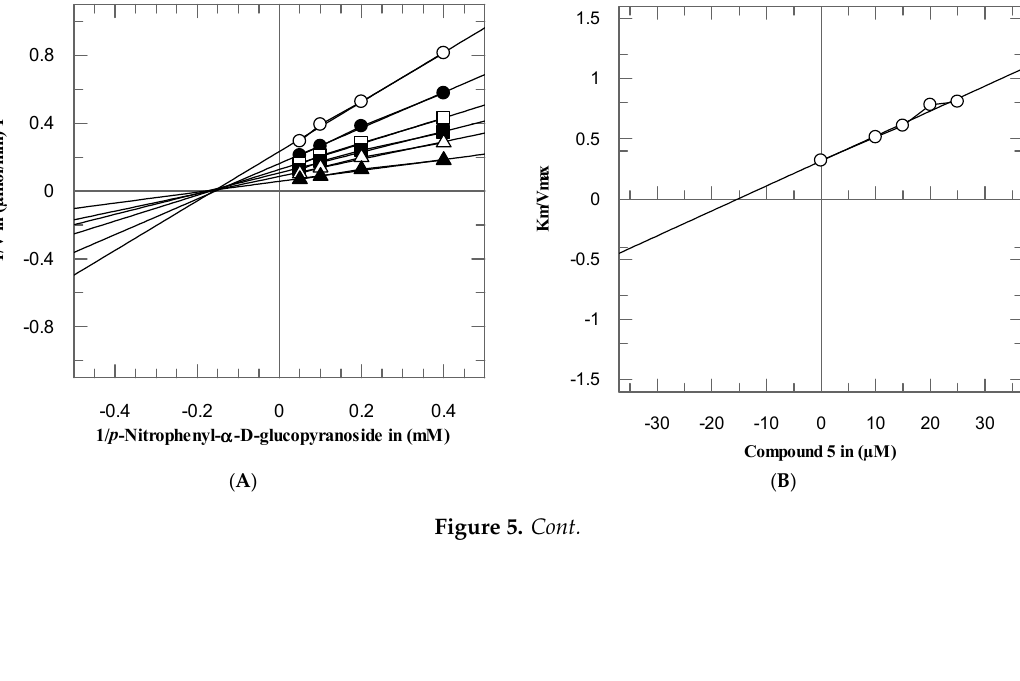
( C ) Figure 5. The inhibition of α -glucosidase by compound 5 ( A ) Lineweaver – Burk plot of reciprocal of rate of reaction (velocities) vs. reciprocal of substrate ( p -nitrophenyl- α -D-glucopyranoside) in the absence ( ▲ ), and in presence of 10 ( ∆ ), 15 ( ■ ), 20 ( □ ), 20 ( ● ), and 25 μ M ( ○ ) of compound 5 . ( B ) Secondary replot of Lineweaver – Burk plot between the slopes of each line on Lineweaver – Burk plot vs. different concentrations of compound 5 . ( C ) Dixon plot of reciprocal of rate of reaction (velocities) vs. different concentrations of compound 5 . ( A ) ( B )